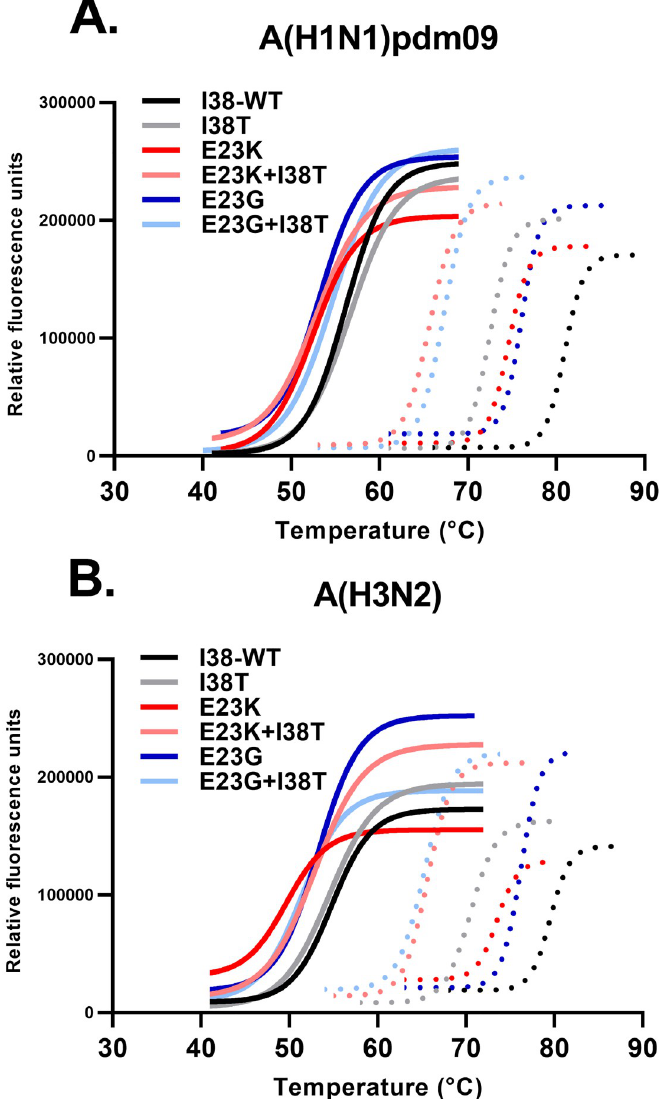
Fig 4. Thermal stability of BXA-rPA N with E23G/K substitutions. The thermal stability of BXA-rPA N complexes was assessed in a modified thermofluor assay. rPA N (2 μ M) from the A) A(H1N1)pdm09 or the B) A(H3N2) subtype was incubated with vehicle (DMSO, solid lines) or BXA (37 μ M, dotted lines), along with SYPRO Orange and progressively heated at 1˚C/min. The emitted SYPRO signal was read at each step. Thermal melt curves were fitted by the Boltzman sigmoidal equation and trimmed at the extreme of each fitted curve. The curves were used to estimate the 50% melting temperatures (T m ) and the change between the curves for vehicle treatment and BXA treatment ( Δ T m ) (Table 4). The results are representative of five independent experiments with triplicate replicates for each sample.